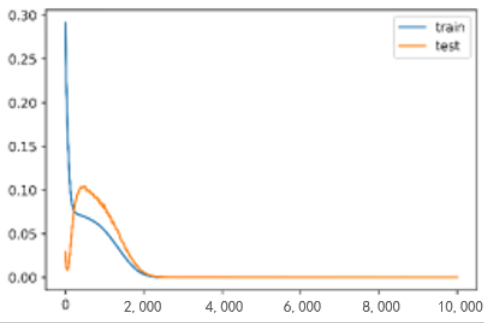
Figure 9. The auto-regressive training result of LSTM.